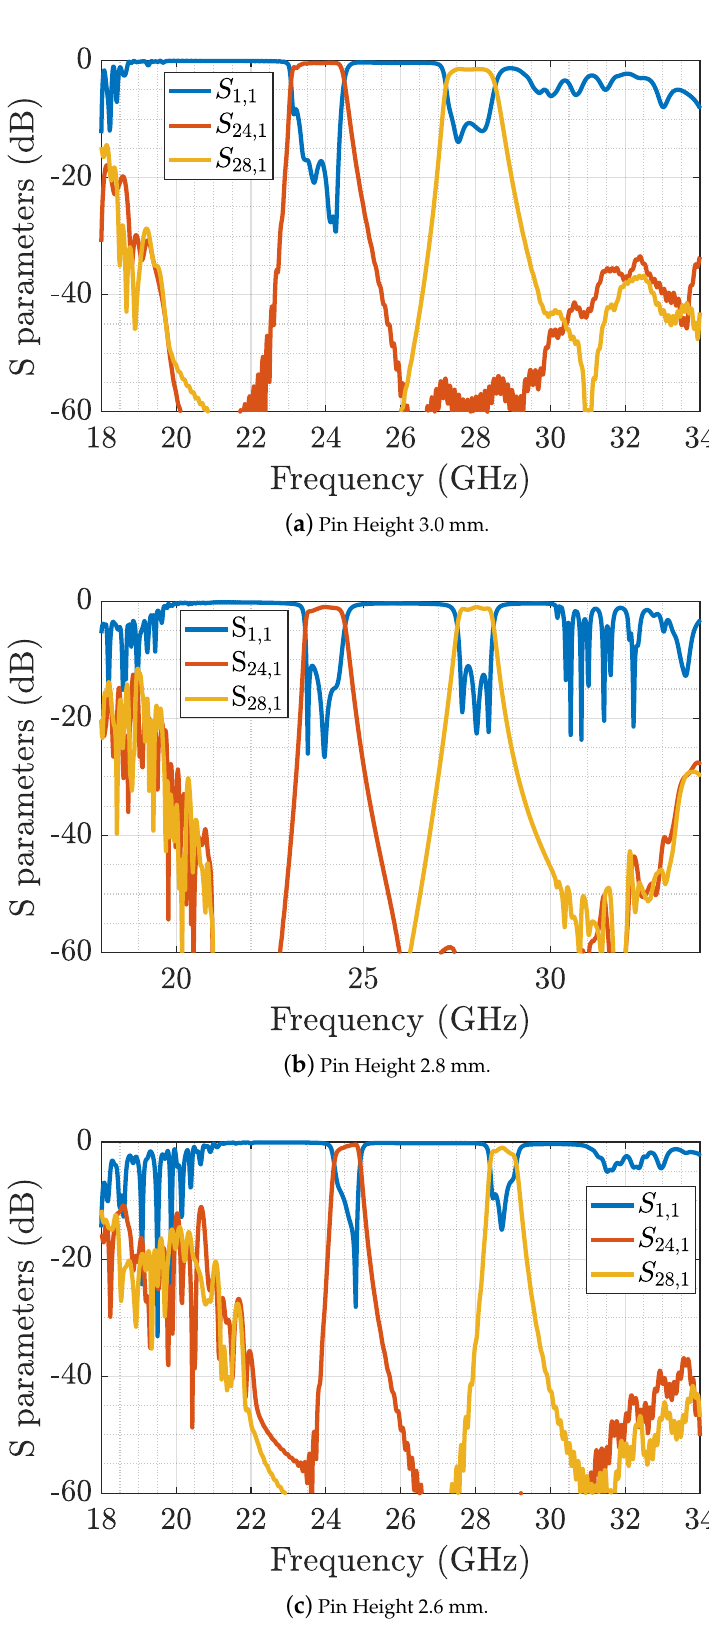
Figure 7. S-parameters for RT5880 TM substrate diplexer vs stopband due to pin